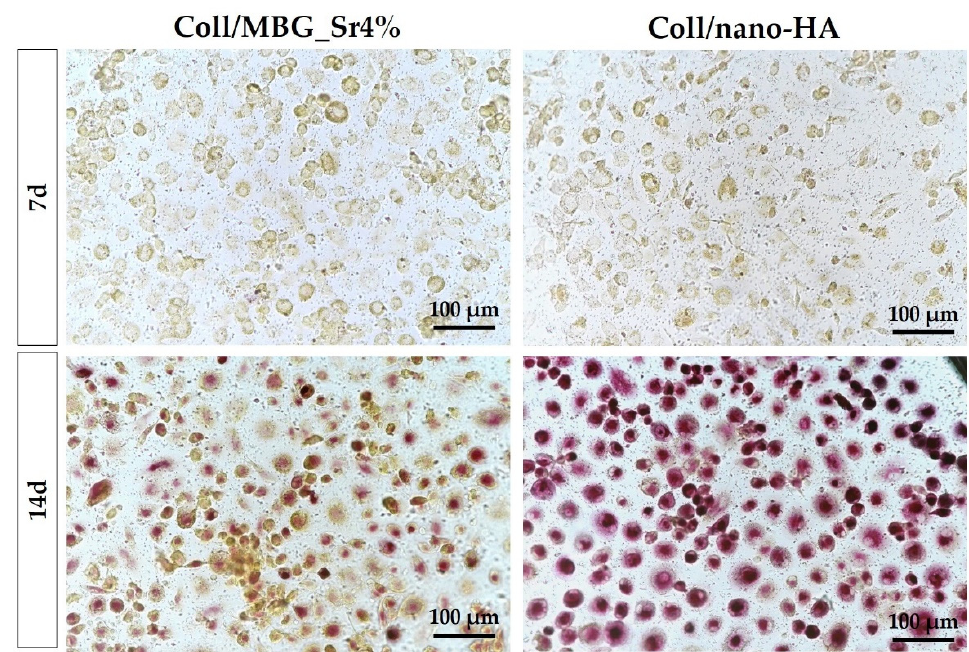
Figure 12. TRAP staining of PBMCs/pre-OCs on transwells in the indirect co-culture with OB-loaded materials at 7 and 14 days.